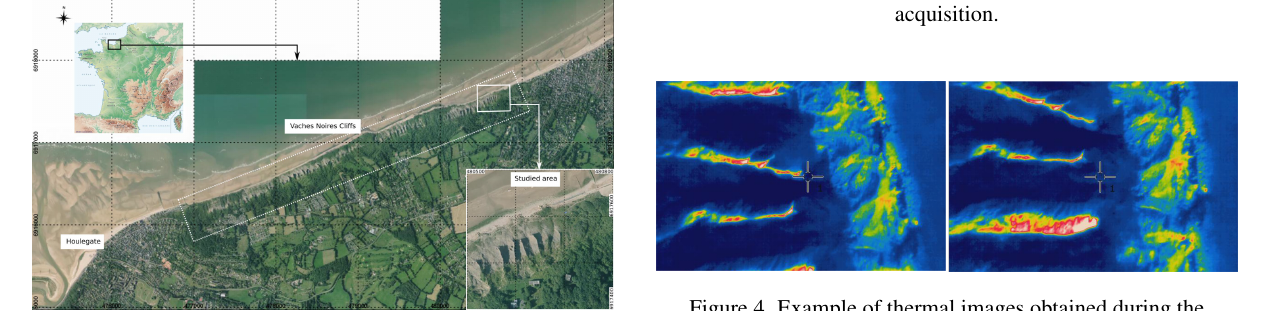
Figure 1. Location of the Vaches Noires cliffs landslide.